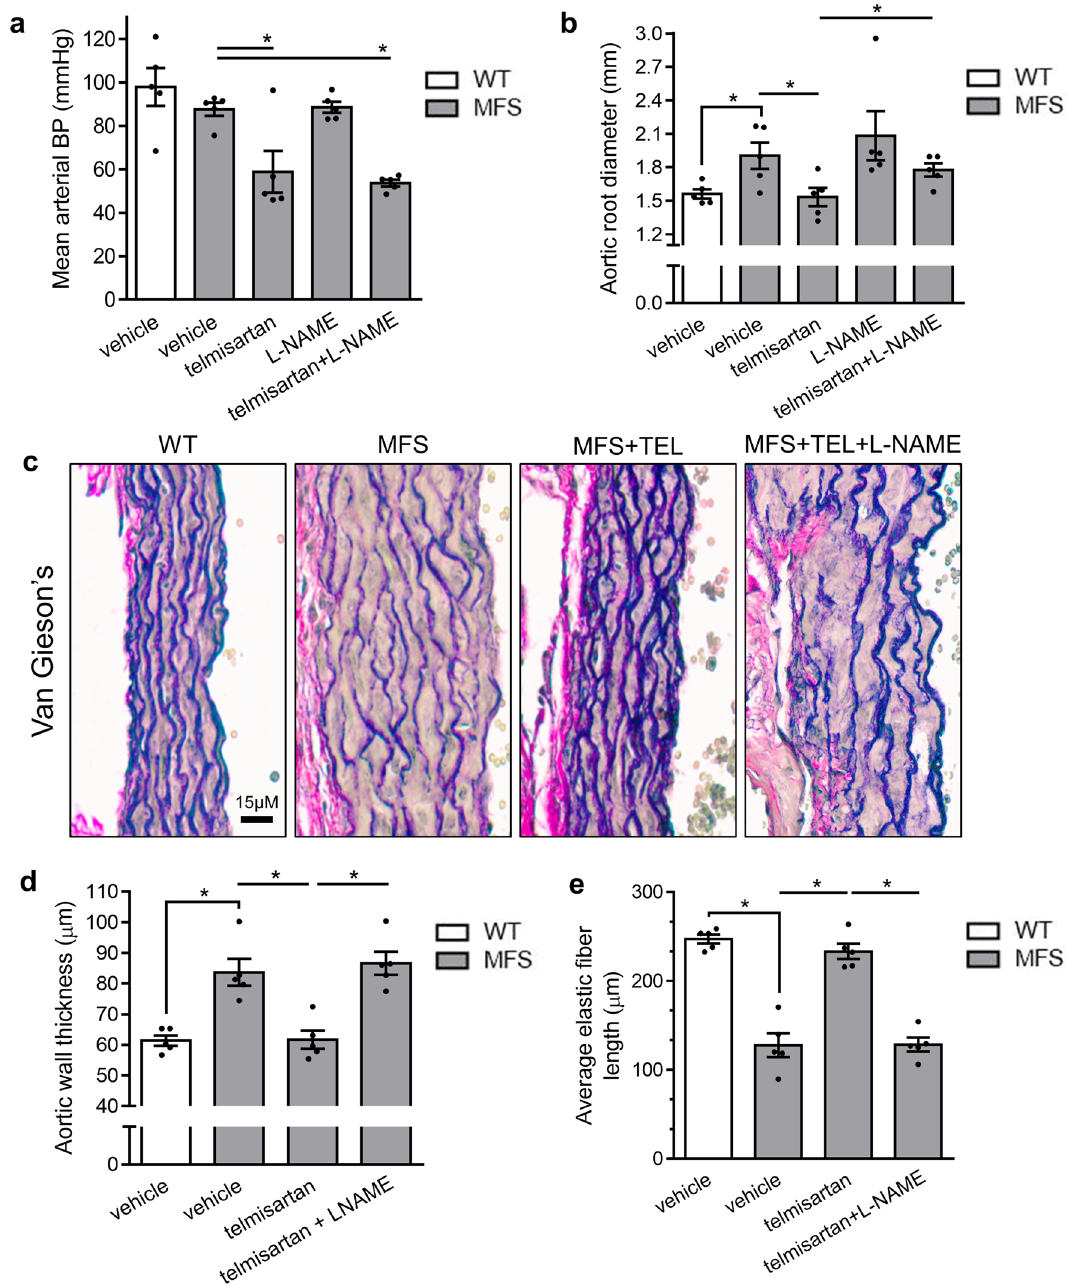
Figure 7. Telmisartan (TEL) inhibits MFS-associated aortic root pathology in a NOS-sensitive fashion. ( a ) Long-term treatment with telmisartan results in reduced BP in MFS mice, an effect that is sustained during co-treatment of telmisartan with L-NAME. ( b ) Telmisartan loses its anti-aortic root widening effects following long-term co-treatment of telmisartan with L-NAME in MFS mice. ( c ) Representative Van Geison’s staining of aortic roots of WT and MFS mice treated with telmisartan and/or L-NAME. Co-treatment with telmisartan and L-NAME abolishes telmisartan’s effects on ( d ) decreasing aortic wall thickness and ( e ) increasing elastic fiber length. (n = 5 for all